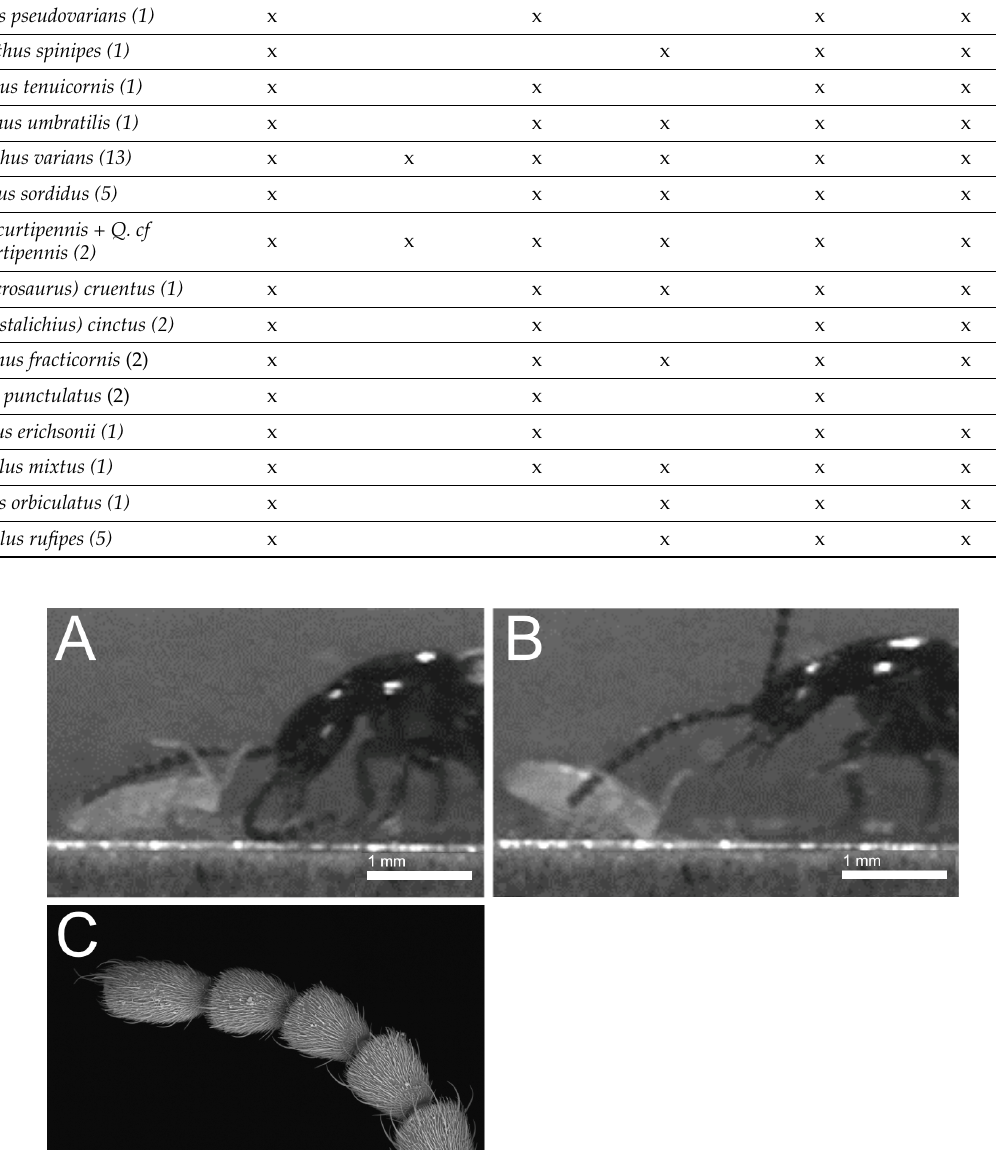
Figure 15. Plot of linear discriminant analytical separation of the tribes. Small transparent shapes represent individual species, large dark shapes represent group centroids. Only one species was analysed for Othiini and Xantholinini. The data (Appendix A, Table A1) were log10-transformed prior to the analysis. Only the first discriminant function, separating Stilicina from the Quediina and Philonthina, is plotted. It shows the following standardized canonical discriminant coefficients: head length/pronotum length: − 0.60; PC1: 0.76.